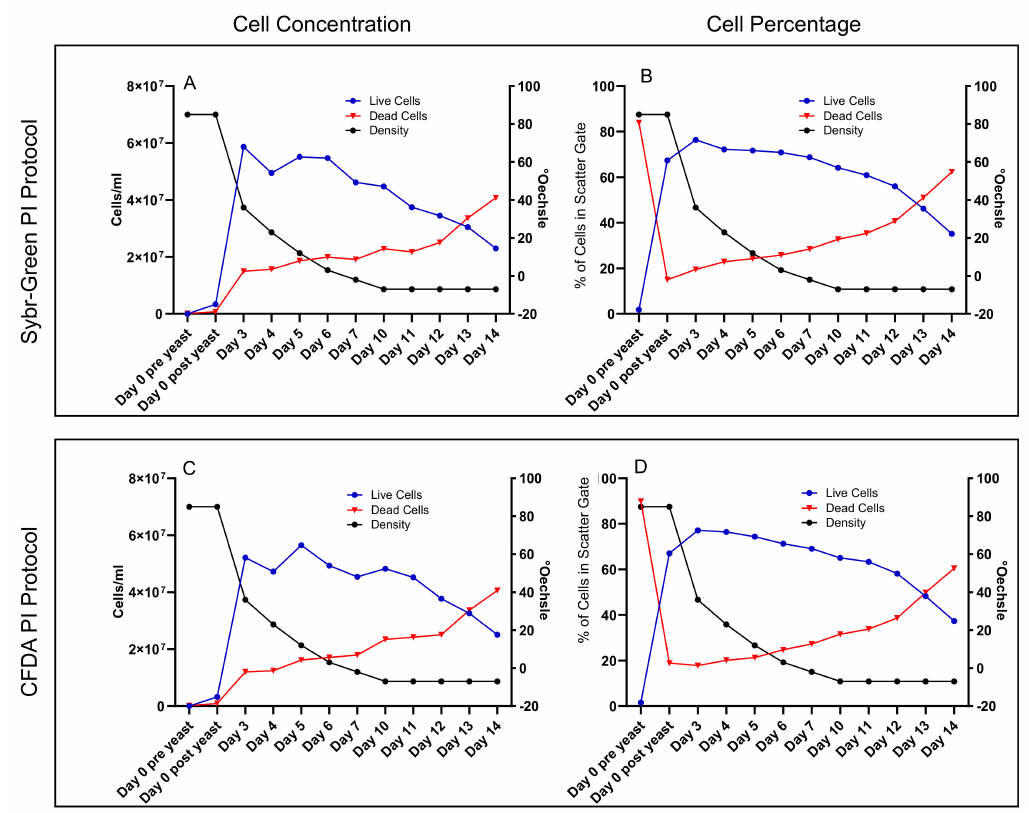
Figure 3. Yeast growth dynamics by FCM as defined by the two staining protocols, SYBR-PI and CFDA-PI. ( A , C ) show the concentration of live and dead cells, whereas ( B , D ) show the percentage of cells in the scatter gate (i.e., parent gate).